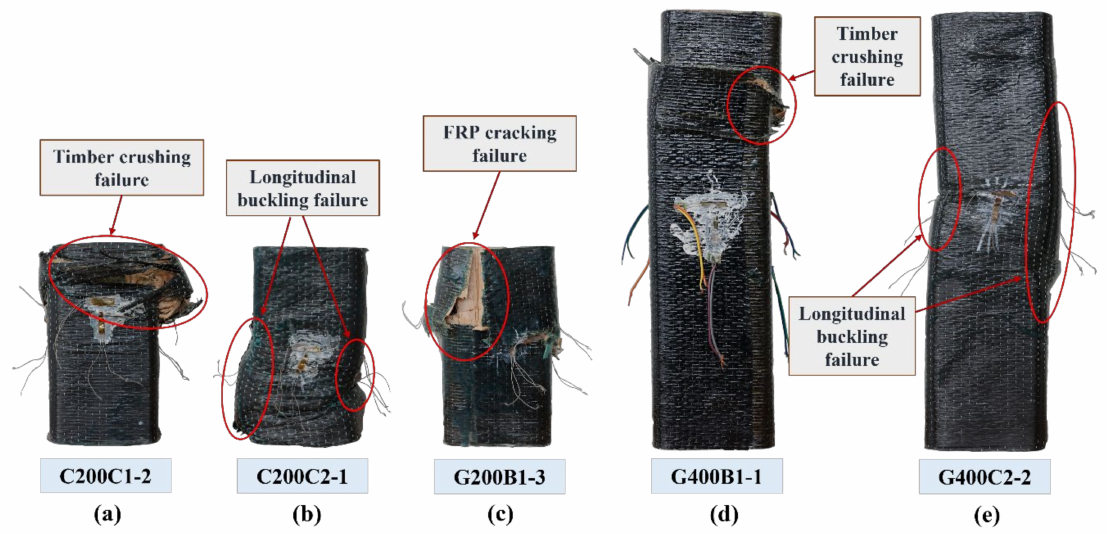
Figure 6. Typical failure modes of specimens: ( a ) C200C1-2; ( b ) C200C2-1; ( c ) G200B1-3; ( d ) G400B1-1; ( e )